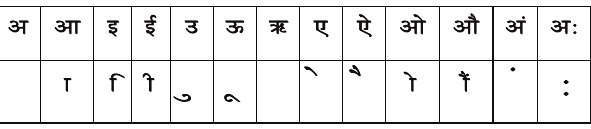
Figure 5: Devnagari Vowels and modifiers.